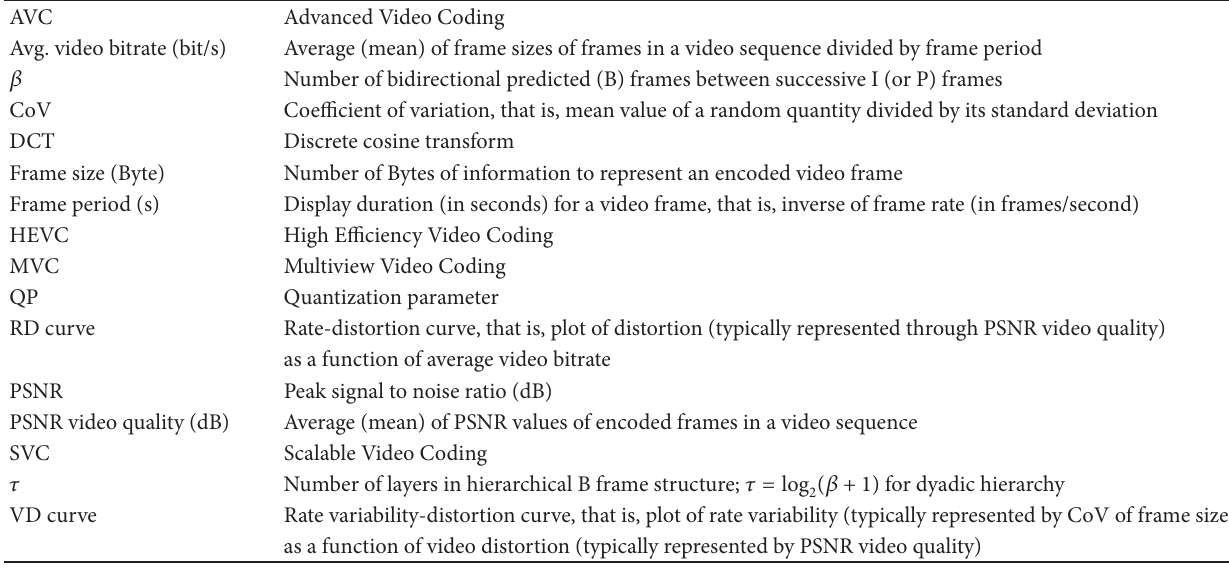
Table 1: Summary of main terminology and